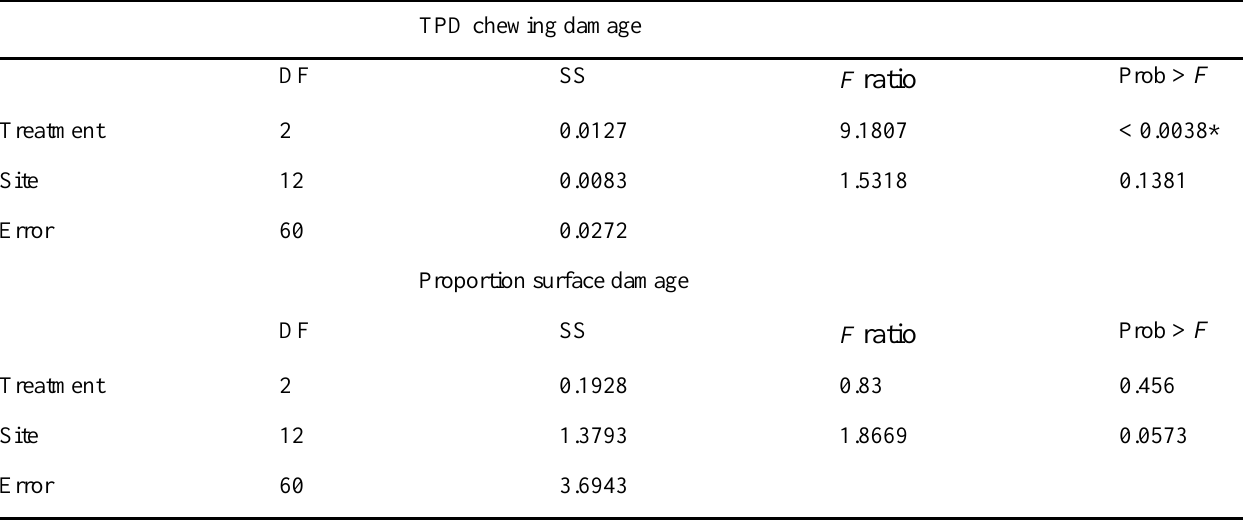
Table 2. Nested analysis of variance for the total proportion of damage (TPD) caused by chewing damage and the proportion of surface damage sustained by Angophora costata in small remnant, edge, and interior sites ( n = 15, * denotes significance at P <